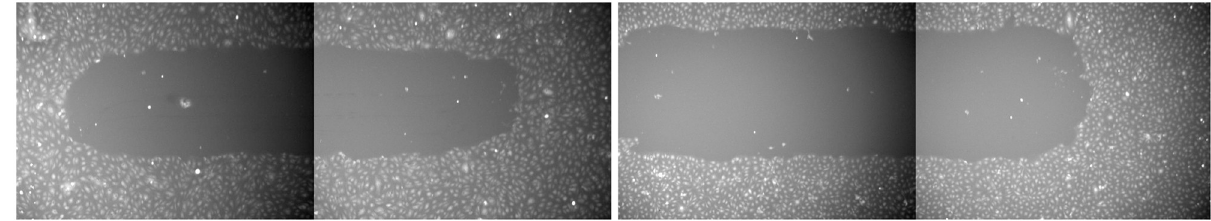
Fig 2. Two initial conditions from the assays conducted on wild-type cells. Note the variation in both the location of the wound as well as the size of the initial wound, highlighting the need to carry out separate simulations, one for each initial condition.